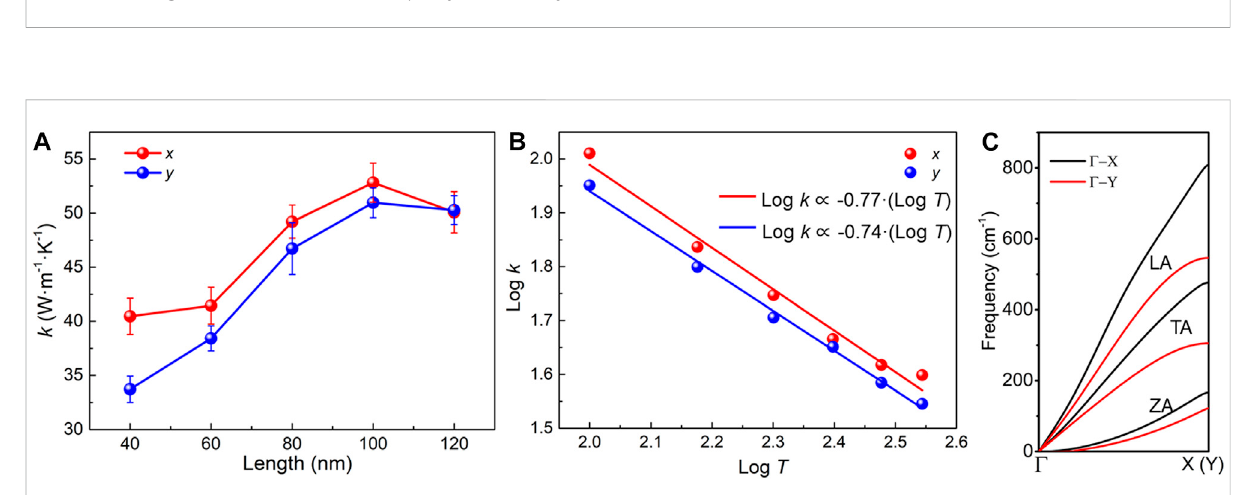
FIGURE 1 Schematic diagram of heat transfer in the biphenylene